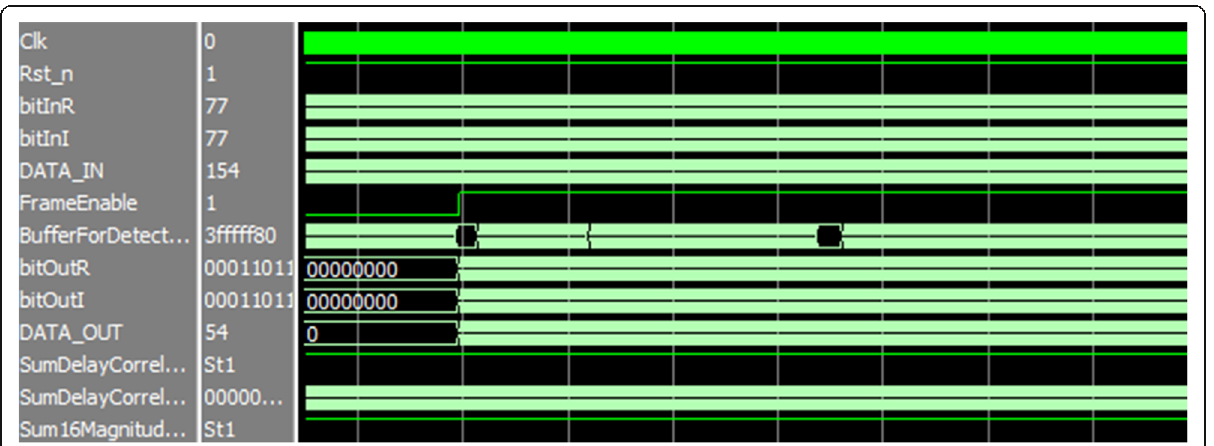
Fig. 5 The simulation diagram 1 of group detection. The value of m n for group detection can be determined by the leading structure when the signal-to-noise ratio (SNR) is 15 dB